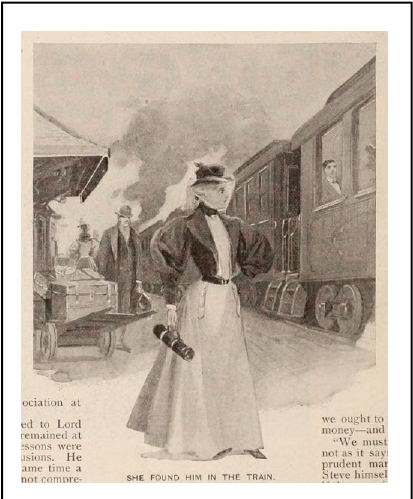
Figure 5. Jesse at the Train Station. Christian Herald , 6 January 1897, p. 12.